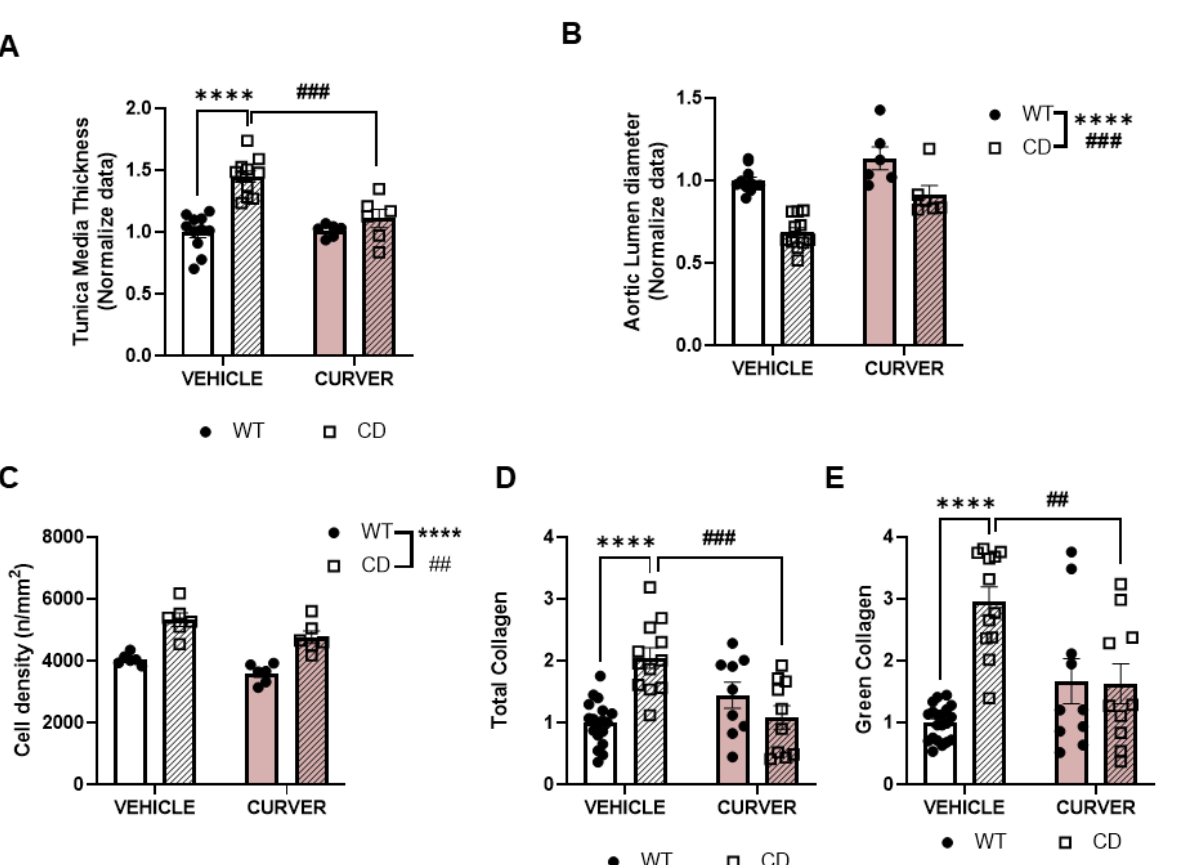
Figure 2. CURVER treatment prevented CD-associated ascending aortic stenosis. ( A ) Tunica media wall thickness in CURVER-treated CD mice was significantly reduced with respect to CD-vehicle ( p = 0.0004). ( B ) A general effect of treatment could be observed in aortic lumen diameter. ( C ) A reduction in cell density, without genotype interaction, could be observed in CURVER-treated ani- mals. ( D ) A significant genotype/treatment interaction was observed for total (F 1, 45 = 20.81, p < 0.0001) and ( E ) green (F 1, 48 = 19.20, p < 0.0001) collagen levels. All data were normalised to WT values.